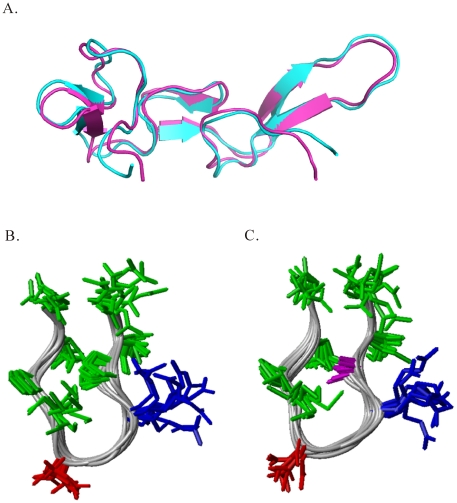
A structural comparison of Rho and its P48A mutant.(A) Superimpositions of the 3D structures of Rho (2PJF, cyan) and its P48A mutant (2PJI, light purple). Structural alignments of (B) the nine-residue RGD loop containing RI[P/A]RGDMPD sequences of Rho and (C) its P48A mutant. Ten of twenty Rho and its P48A mutant structures were aligned; the RMS deviations of the nine-residue backbone atoms of Rho and its P48A mutant were 0.551 and 0.475 Å, respectively. The side chains of A48, R49, D51, and others are shown in purple, blue, red, and green, respectively.